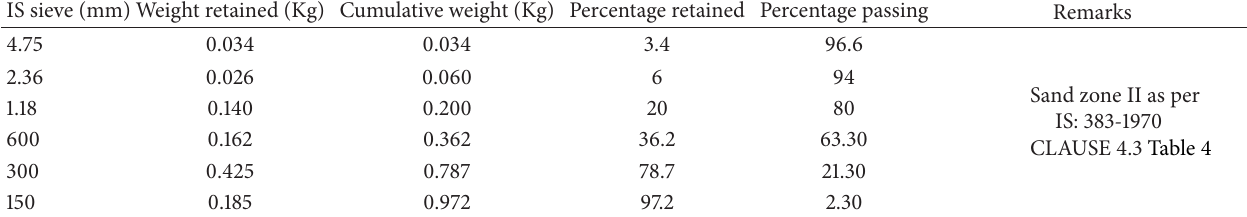
Table 6: Sieve analysis of fine aggregate.